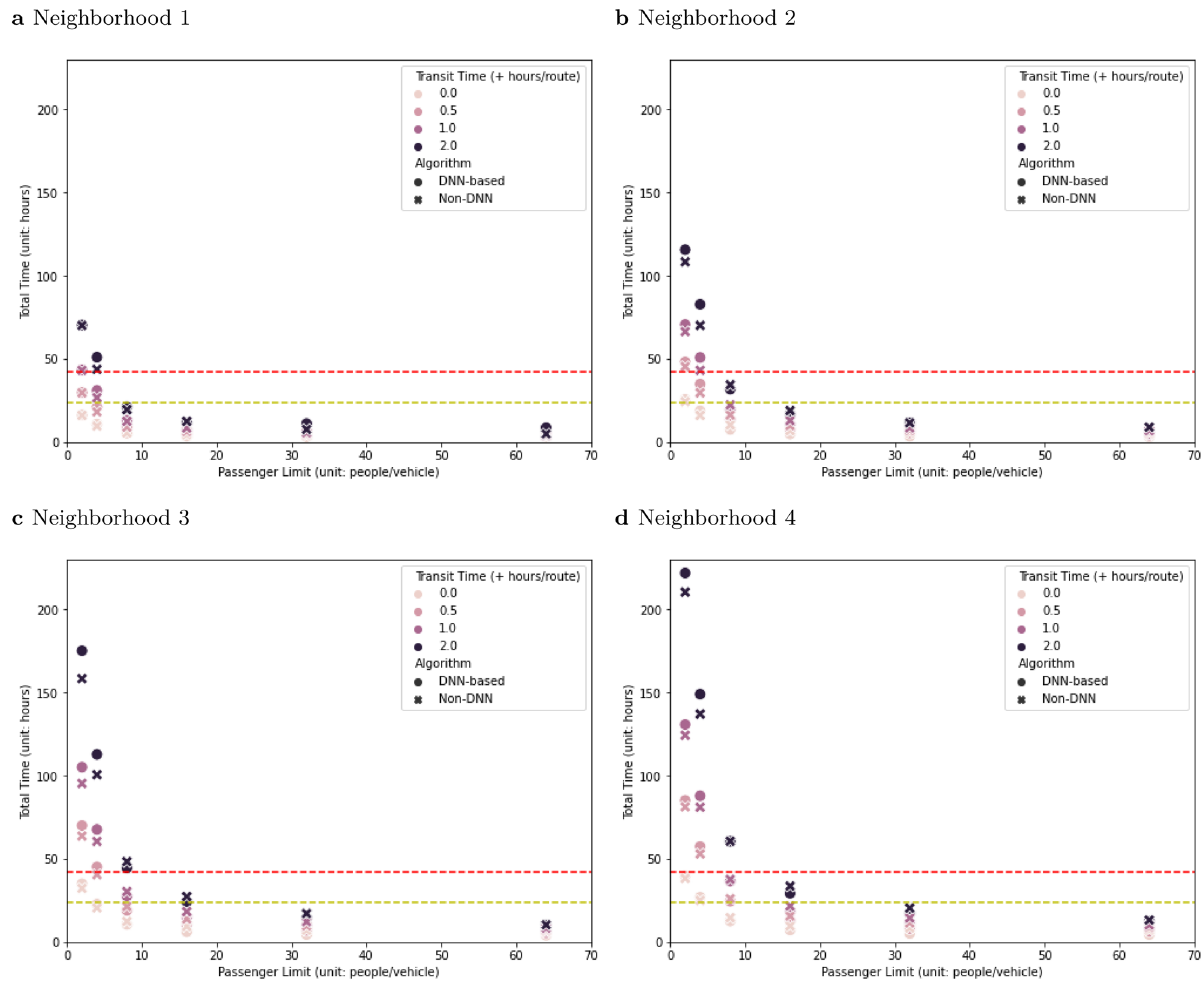
Figure 5. Social distancing and total evacuation time for a neighborhood. The x-axis indicates different social distancing protocols (the number of people allowed in an emergency vehicle) and y-axis indicates the total time required to evacuate a neighborhood. Red and yellow dashed lines indicate the 42-h and 24-h windows, respectively (Fig. 2). ( a ) Neighborhood 1 has 52 people and 20 houses on the special needs registry. ( b ) Neighborhood 2 has 83 people and 35 houses. ( c ) Neighborhood 3 has 126 people and 52 houses. ( d ) Neighborhood 4 has 168 people and 68